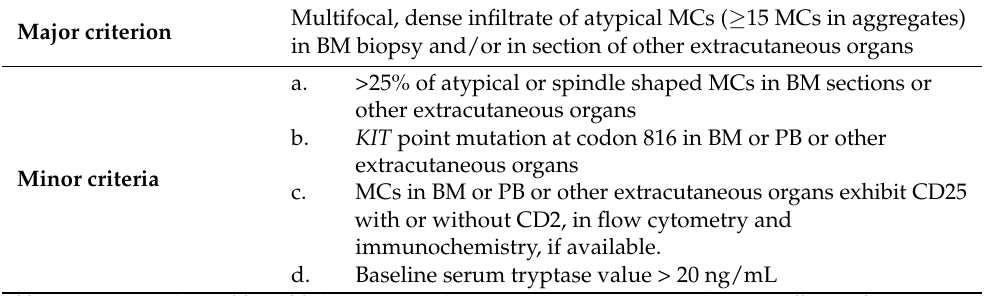
Table 2. Diagnostic Criteria for Systemic Mastocytosis (SM) according to the 2016 WHO classification. Major